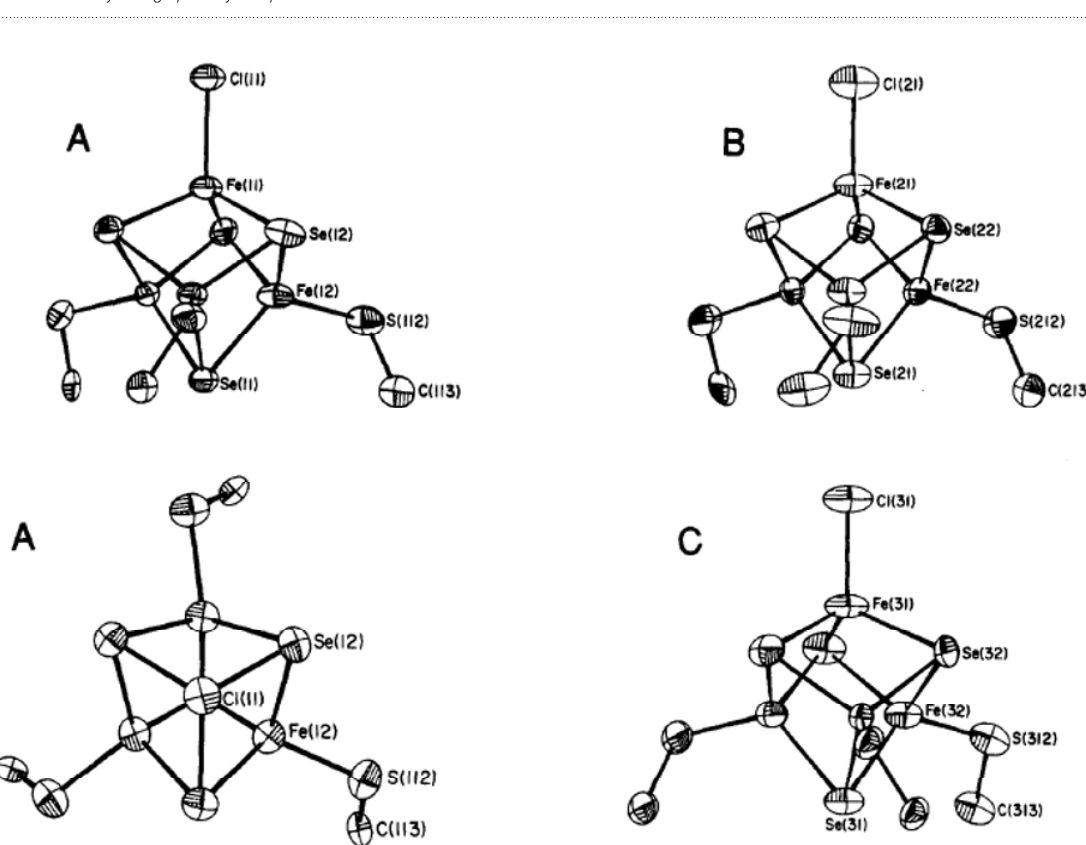
Figure 5. Structure of [Fe II/III (µ